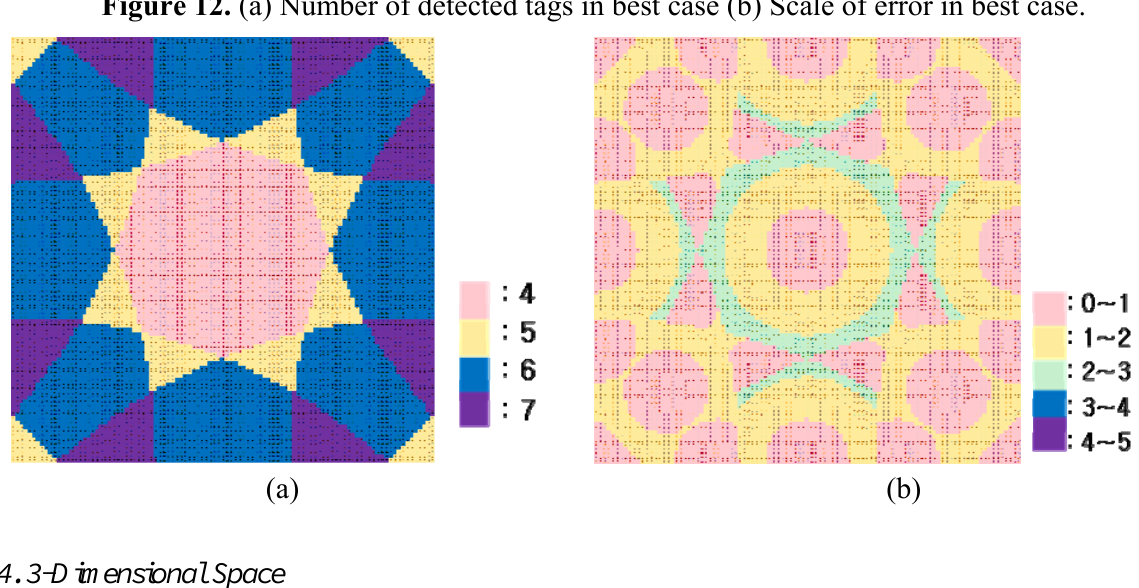
Figure 12. (a) Number of detected tags in best case (b) Scale of error in best